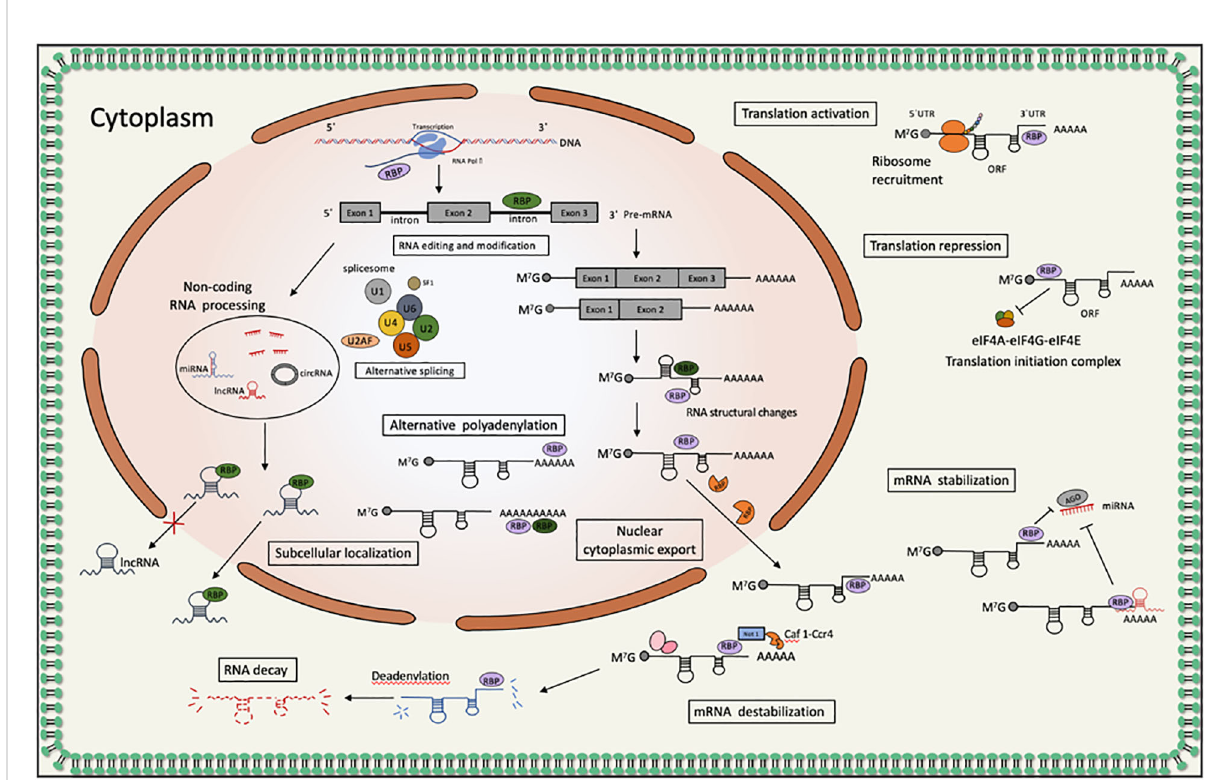
FIGURE 1 PABPs proteins act as RNA binding proteins involved in post-transcriptional regulation of gene expression in tumors: bind the poly(A) tail of mRNA, including those of their own transcripts, and regulate processes of mRNA metabolism such as pre-mRNA splicing, alternative polyadenylation and mRNA stability; participate in microRNA-induced target gene inactivation and nonsense-mediated mRNA decay; regulate translation initiation and involved in translationally coupled mRNA